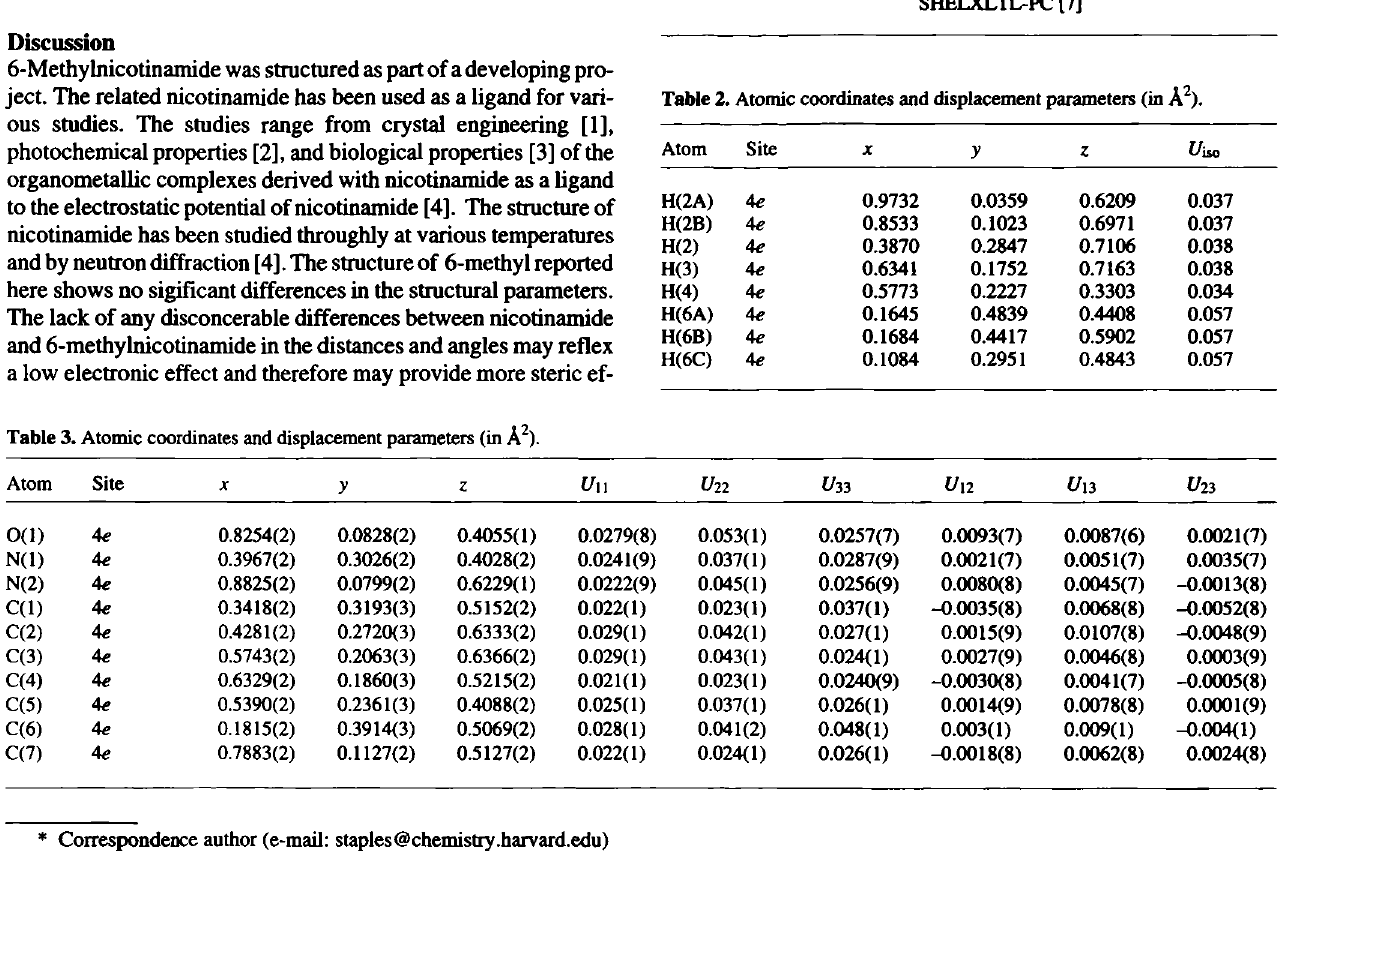
Table 3. Atomic coordinates and displacement parameters (in À 2